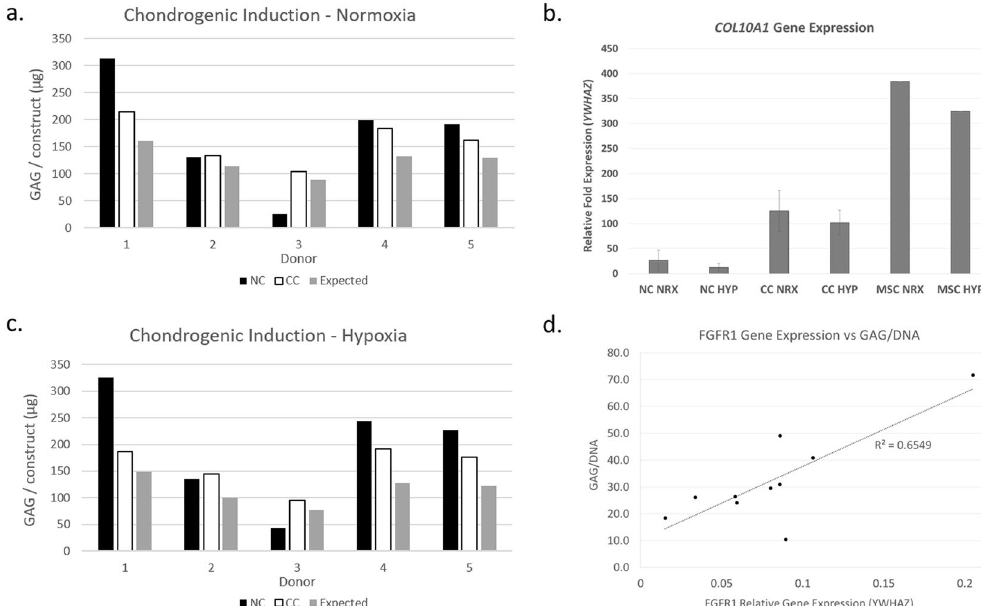
Figure 6. ( a , c ) Interaction index identifying chondro-induction in co-culture for both normoxia (top) and hypoxia (bottom) for all 5 donors. Black bars are nasal chondrocytes, white bars are co-culture and grey is the expected value from the NC and BM-MSC without any interaction. CC values higher than expected values indicated a chondro inductive effect. ( b ) Relative gene expression for COL10A1 for the groups NC, CC and MSC in normoxia (NRX) and hypoxia (HYP) normalized against YHWAZ . ( d ) Regression of GAG/DNA vs gene expression of FGFR1 , showing a positive and significant correlation, R 2 = 0.66, adjusted p <